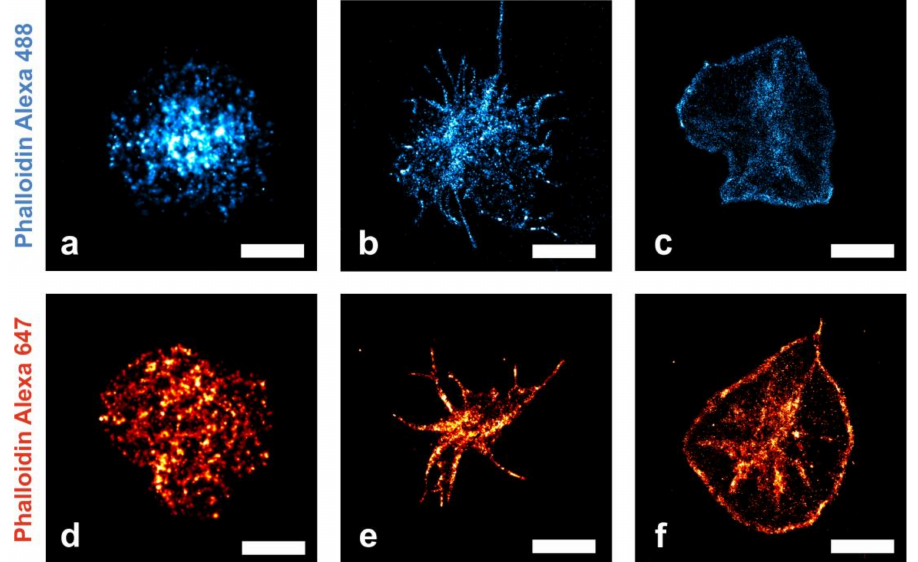
Figure 2. Reconstructed fluorescence microscopy images (dSTORM) of human platelets at three different morphological states (cell culture medium on plain glass support), stained with phalloidin Alexa Fluor 488 (top row) or phalloidin Alexa Fluor 647 (bottom row). F-actin molecules bound by fluorescently labeled phalloidin are represented by the red and blue colored localizations within the cells, respectively. Brighter areas are caused by a higher density of localized